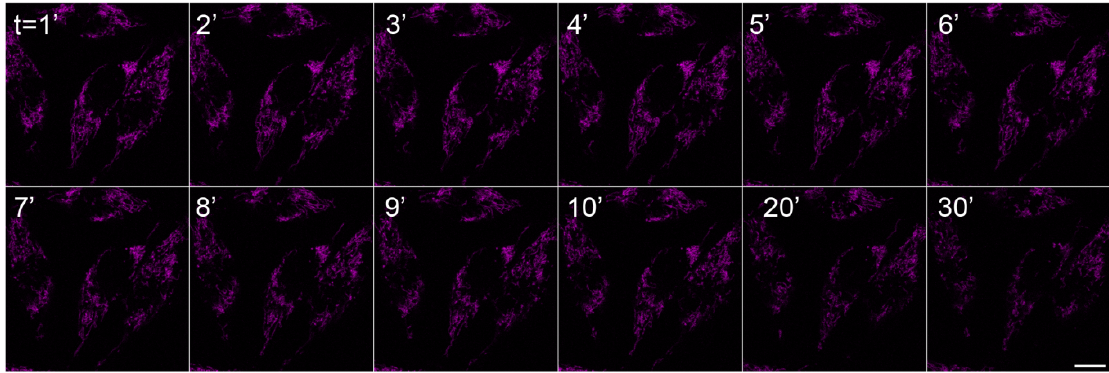
Figure 5. Stability of chemical C2 using low laser intensity settings. 633 nm laser was used at 4% intensity to capture images at indicated time points. Bar 10 µm.